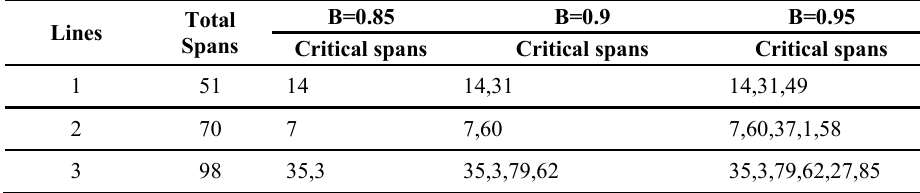
Table 2. Identification results with critical